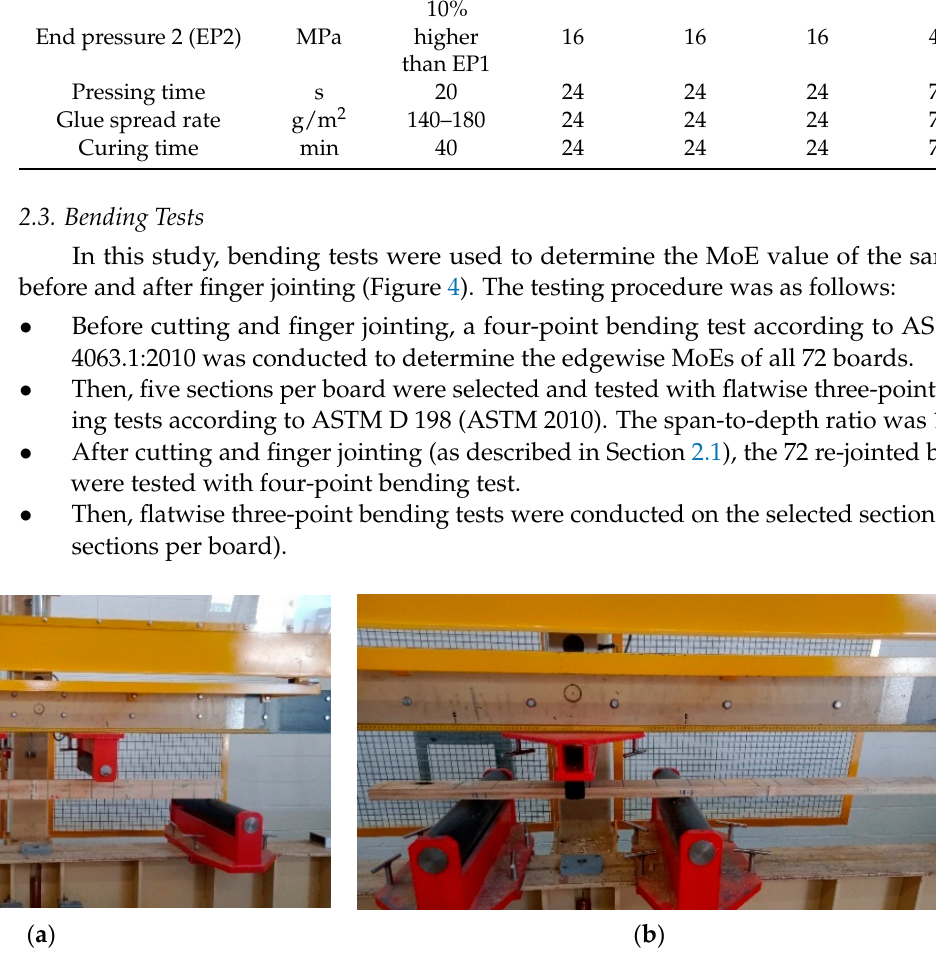
Figure 4. Bending test setups: ( a ) four-point bending test (edgewise); ( b ) three-point bending test (flatwise).